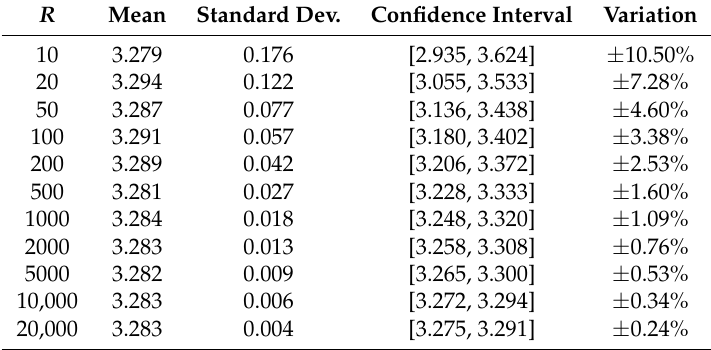
Table A1. Test of the number R of random triangle completions for the risk margin calculation. The mean and standard deviation allow for constructing a Gaussian 95% confidence interval by adding (resp. subtracting) 1.96 times the standard deviation to the mean to obtain the upper (resp. lower) bound. The “Variation” column designates the variation around the mean that represents the 95% confidence interval, i.e., 1.96 times the standard